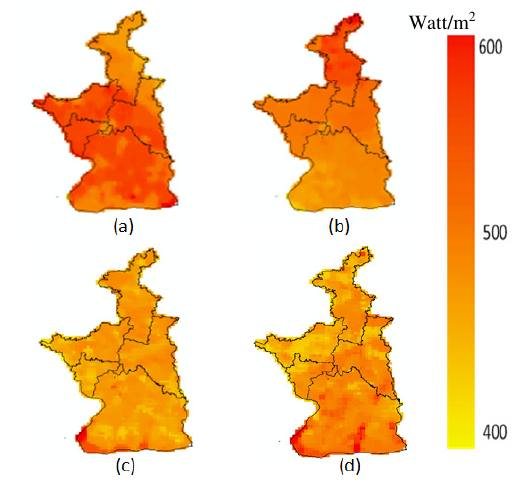
Figure 5: Instantaneous net radiation map corresponding to julian day (a) 10, (b) 28, (c) 38 and (51) of